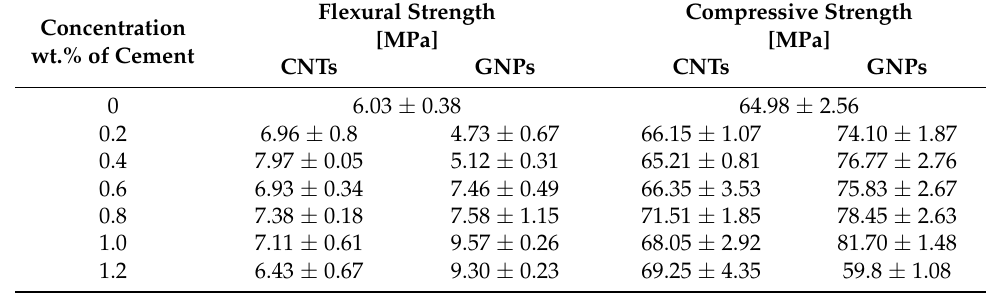
Table 4. Variation of mortars’ strengths with CNT and GNP concentration.